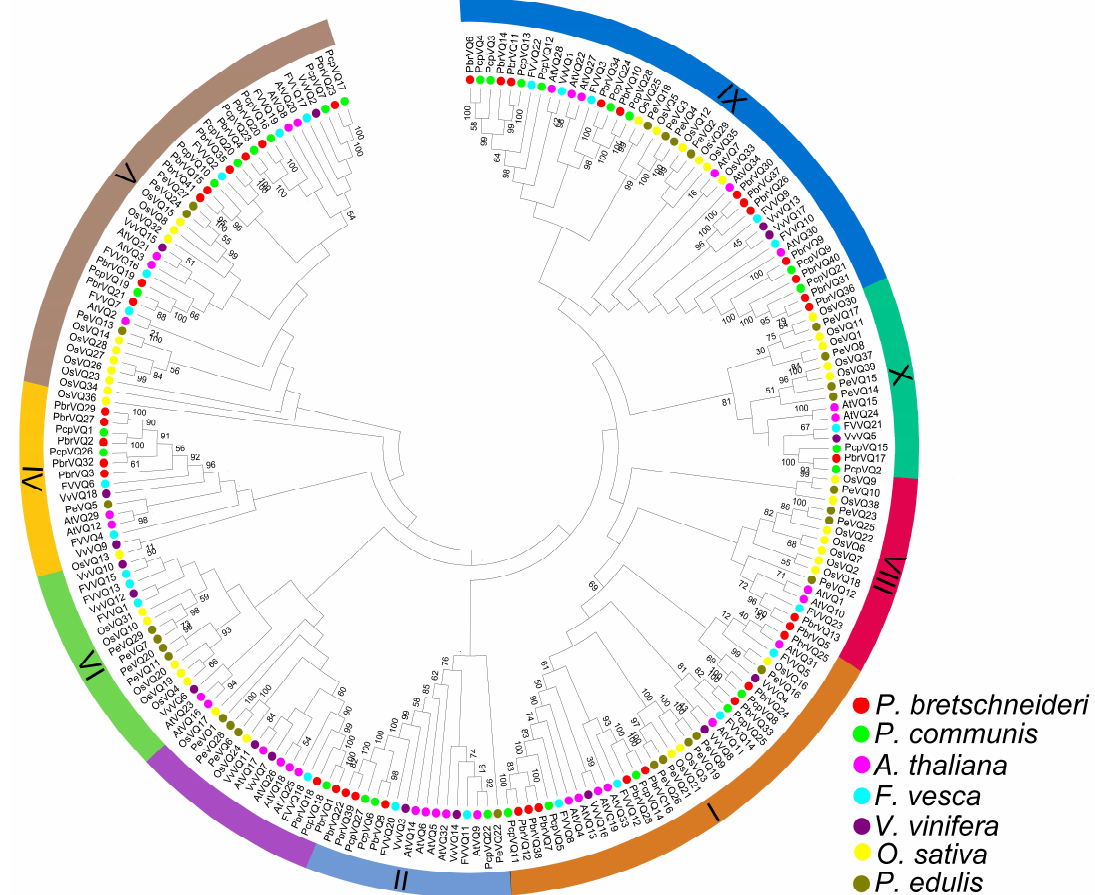
Figure 2. Classification and phylogenetic relationships of P. bretschneideri and P. communis VQ motif-containing genes. The neighbor-joining (NJ) tree was constructed by the full-length amino acid sequences using MEGA 5 software. According to the previously published articles [9], we divided these sequences into nine different subfamilies (I-X). Proteins from P. bretschneideri , P. communis , Arabidopsis thaliana , Fragaria vesca , Vitis vinifera , Oryza sativa , and Phyllostachys edulis are denoted by red, green, pink, blue, purple, yellow, and brown circles, respectively.